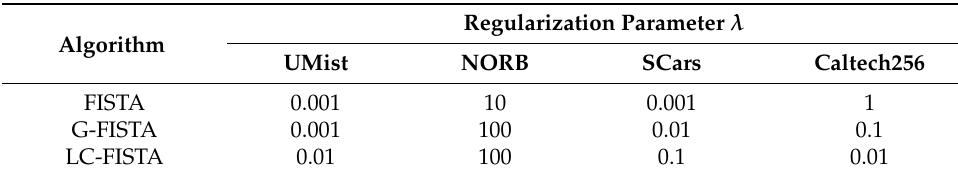
Table 3. Choice of λ for each algorithm and selected